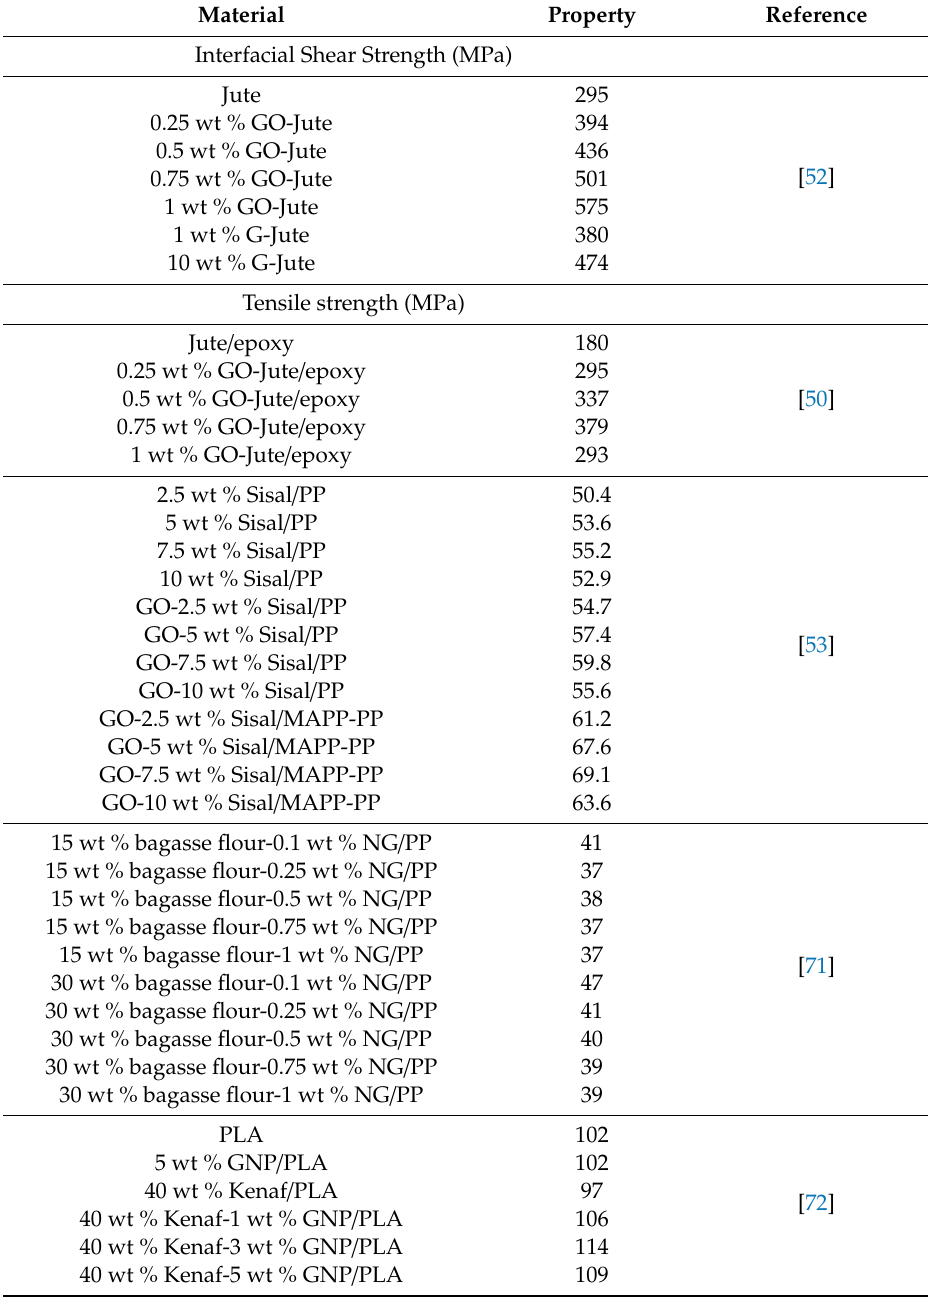
Table 3. Mechanical properties of natural fibers with graphene-based material, and their composites. Material Property Reference Interfacial Shear Strength